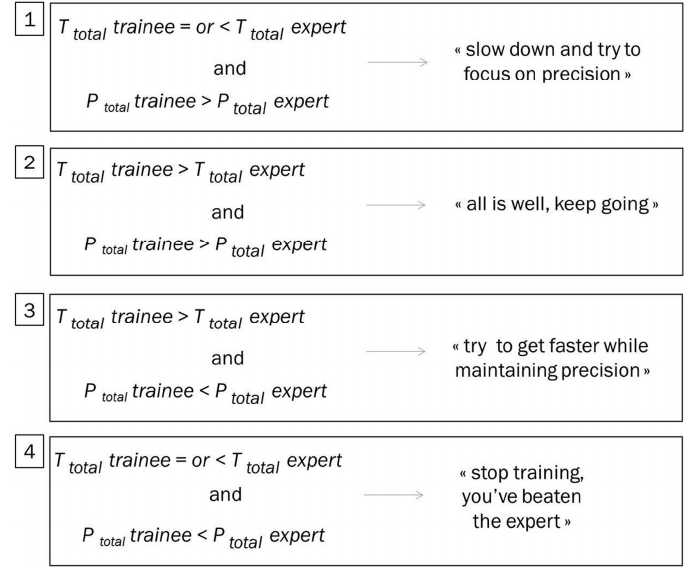
Figure 4. Decision model for the automatic correction or reinforcement of individual strategies during simulator training based on the expert’s benchmark statistics (“learned” system knowledge). No more than four cases (1–4) need to be considered for generating clear performance feedback any novice